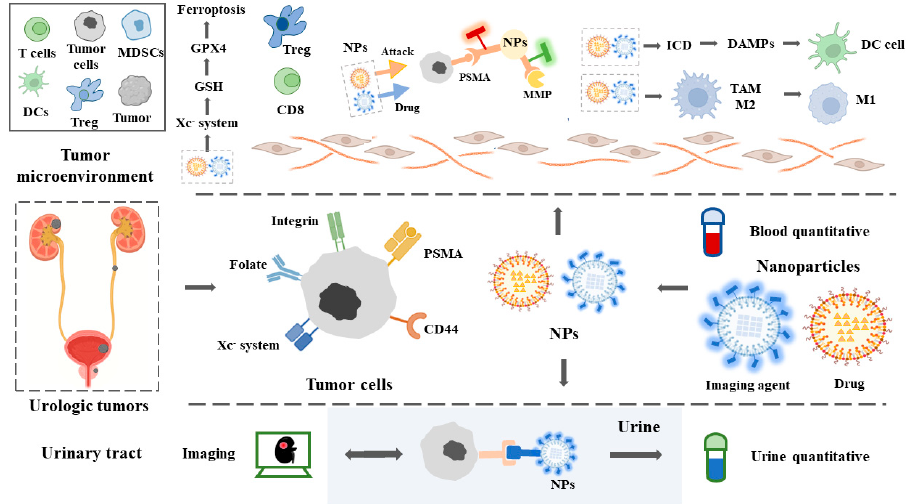
Figure 1. Schematic diagram of imaging, diagnosis, and therapy in urologic tumors using nanomed- icine.